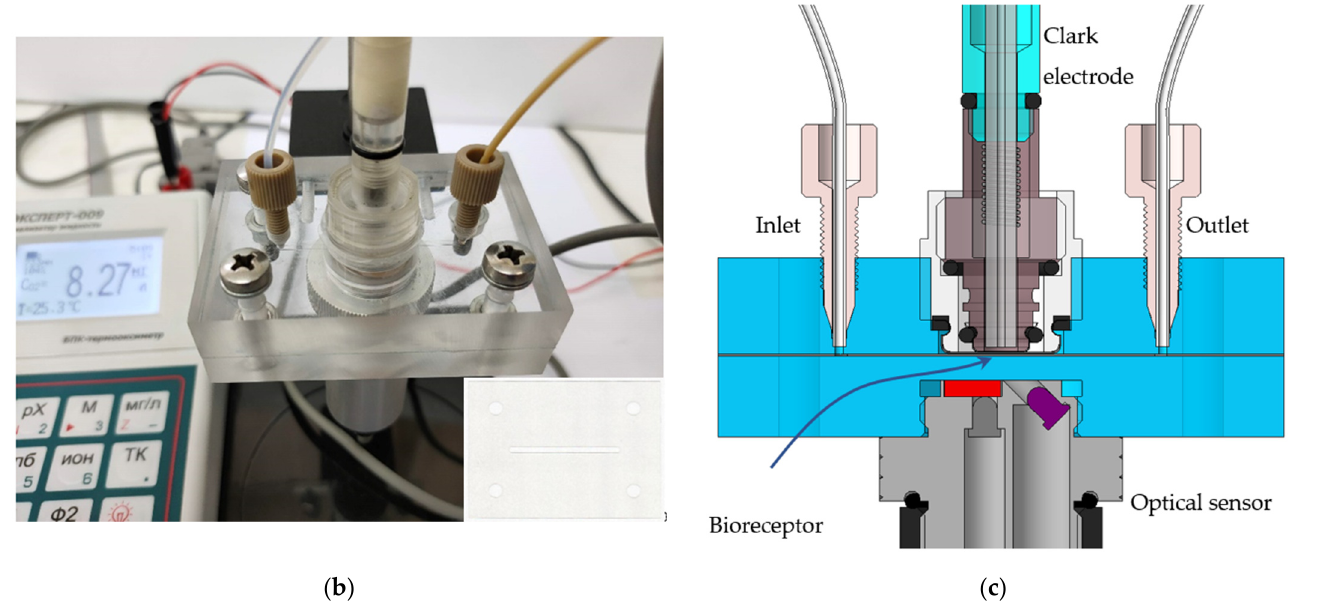
Figure 1. Experimental setup: ( a )—overall view; ( b )—the developed microfluidic cell with installed amperometric Clark electrode (top), optical oxygen sensor (bottom). A PET film with an eluent channel is shown in the inset; ( c ) schematic representation of a microfluidic cell in section, side view. The bioreceptor is placed in the center of the cell directly into the liquid flow, the amperometric (top) and optical (bottom) sensors are in close proximity, performing measurements in the same microvolume.